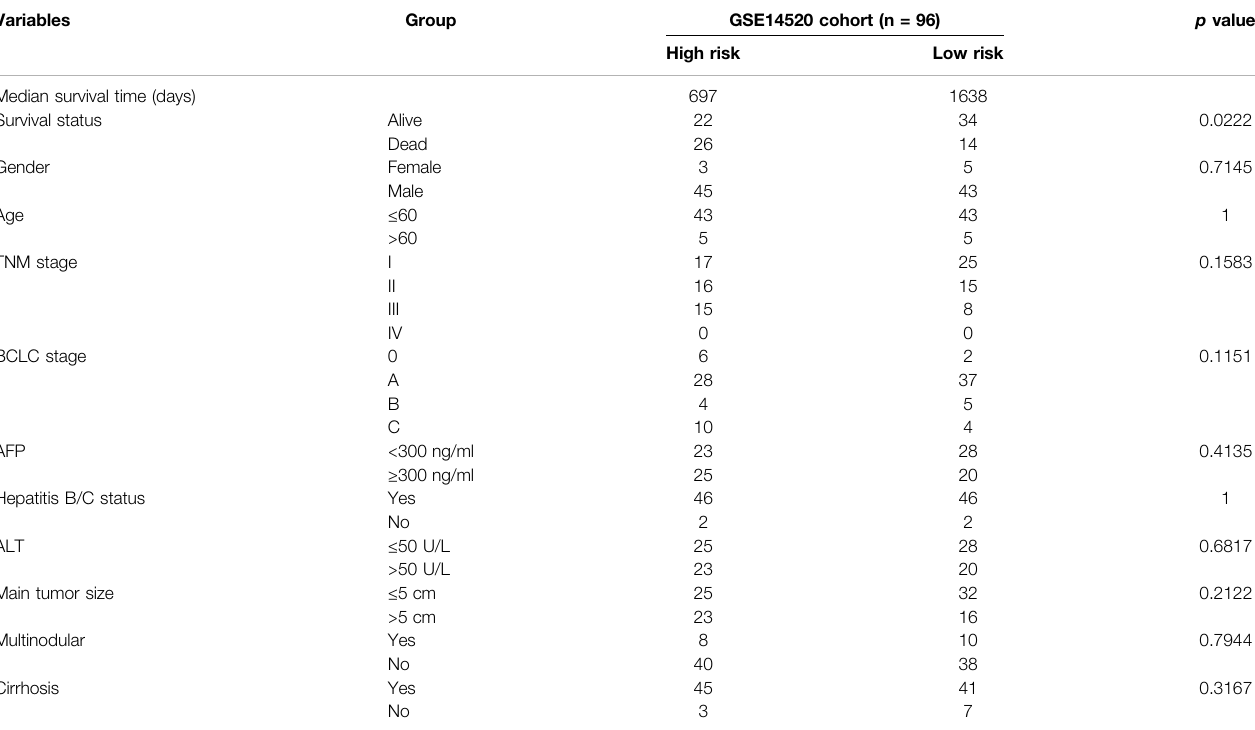
TABLE 2 | Baseline characteristics of the patients in the GSE14520 cohort.